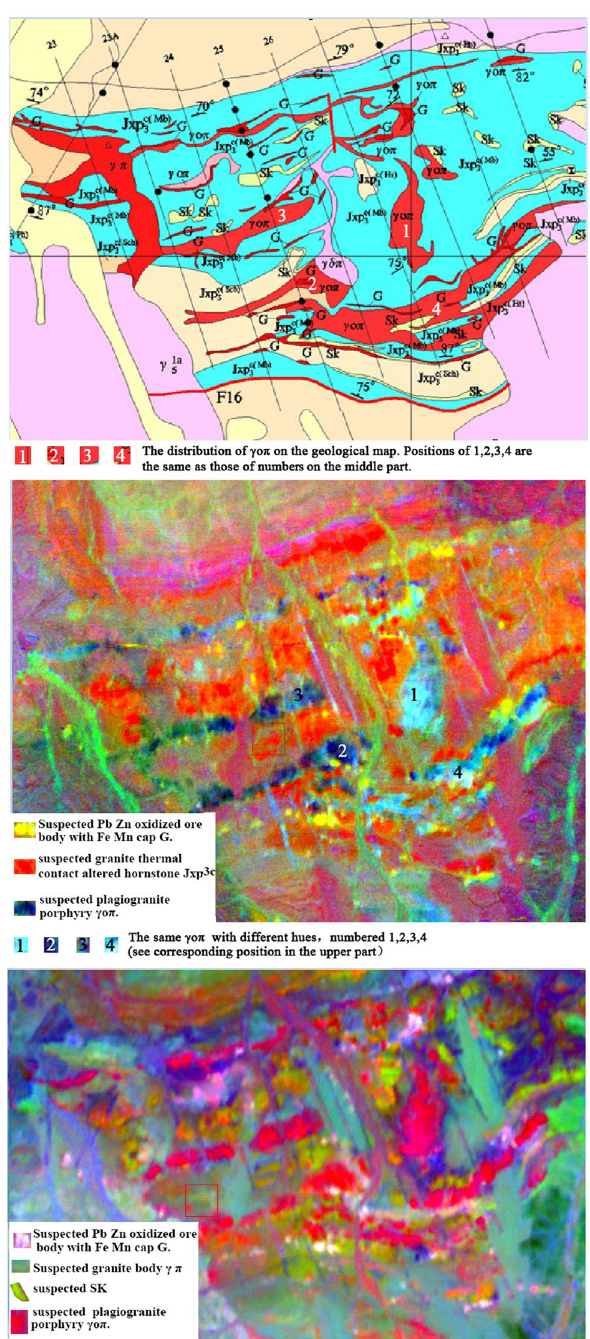
Figure 7. The upper is the mineral geological map of key areas, the middle is the 2nd, 3rd and 14th component combination of MNF, the lower is the 6th, 7th and 8th component combination of MNF. This figure is generated by Yu-Hai Fan, Mou-shun Jin using ENVI (version4.3) created by the ENVI Team under an open license (http:// www.envii